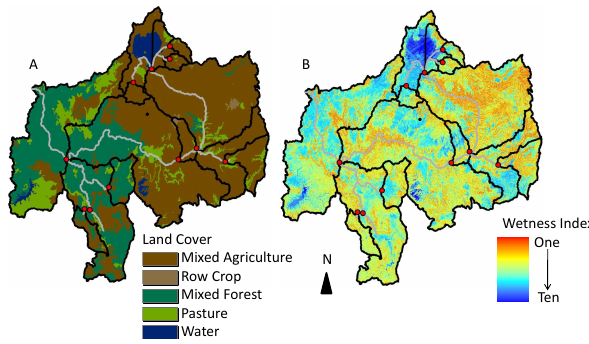
Fig. 2. Landuse/landcover (A) in the Blue Nile Basin (source EN- TRO), and the Wetness Index (B) used in the SWAT-WB Blue Nile